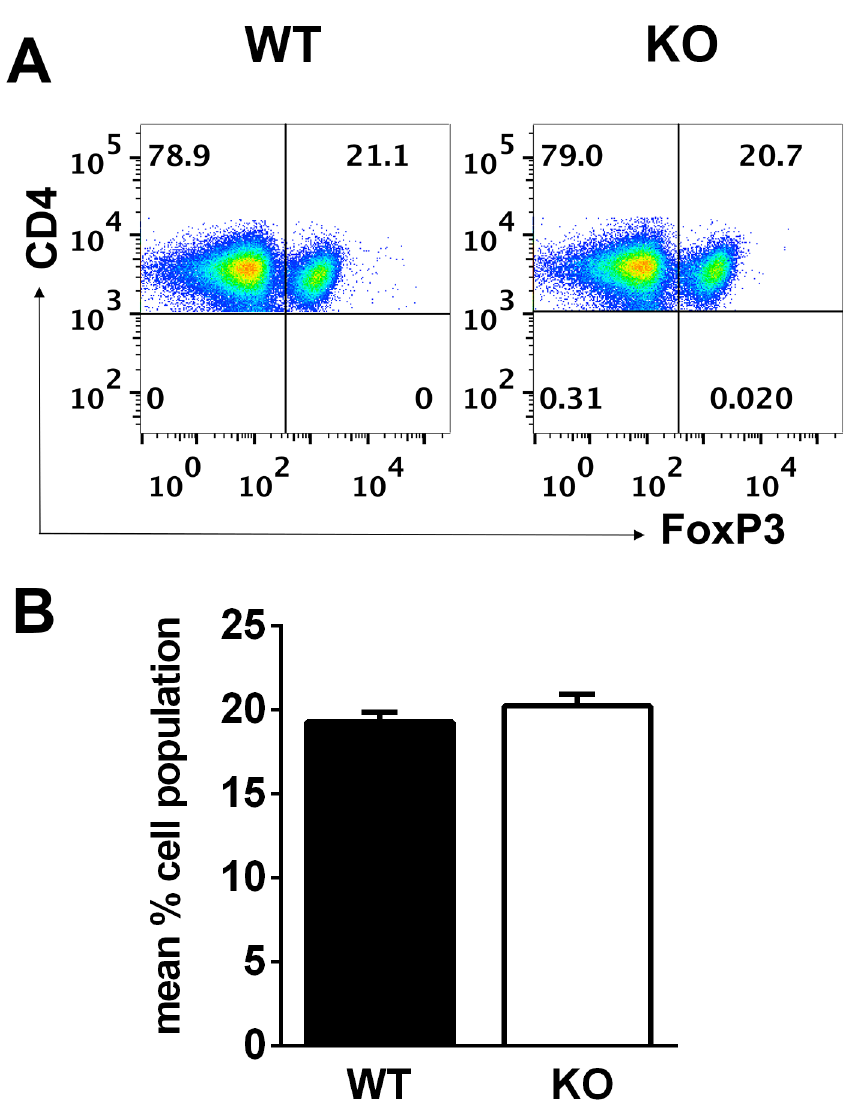
Fig 4. Similar levels of Treg cells expressing FoxP3 in spleens of Lrrk2 (-/-) ( “ KO ” ) and their WT controls. Spleens from mice of the two groups were collected 14 days post immunization, pooled, and their cells were examined by flow cytometry for expression of FoxP3. A . A representative experiment. B . Mean +/- SEM of proportions of FoxP3 cells in spleens of mice of the two groups from five individual